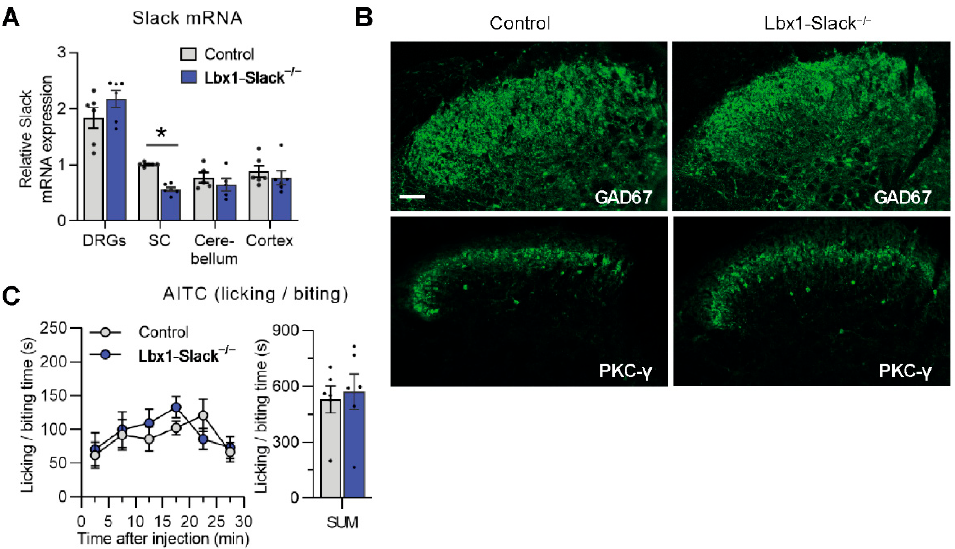
Figure 3. Lbx1-Slack − / − mice display normal AITC-evoked pain behavior. ( A ) Quantitative RT-PCR in lumbar DRGs, lumbar spinal cord, cerebellum, and prefrontal cortex revealed that Slack mRNA levels are selectively reduced in the spinal cord of Lbx1-Slack − / − mice ( p < 0.0001; n = 6 mice per group). ( B ) The distribution of GAD67 + inhibitory interneurons and PKC γ + excitatory interneurons in the dorsal horn appears normal in Lbx1-Slack − / − mice. Scale bar, 50 µ m. ( C ) Time course of paw licking and biting (left) and the sum of licking and biting time over 30 min (right; p = 0.7319; n = 6 mice per group) after intraplantar AITC injection in Lbx1-Slack − / − and control littermates. Data are presented as mean ± SEM. * p < 0.05.